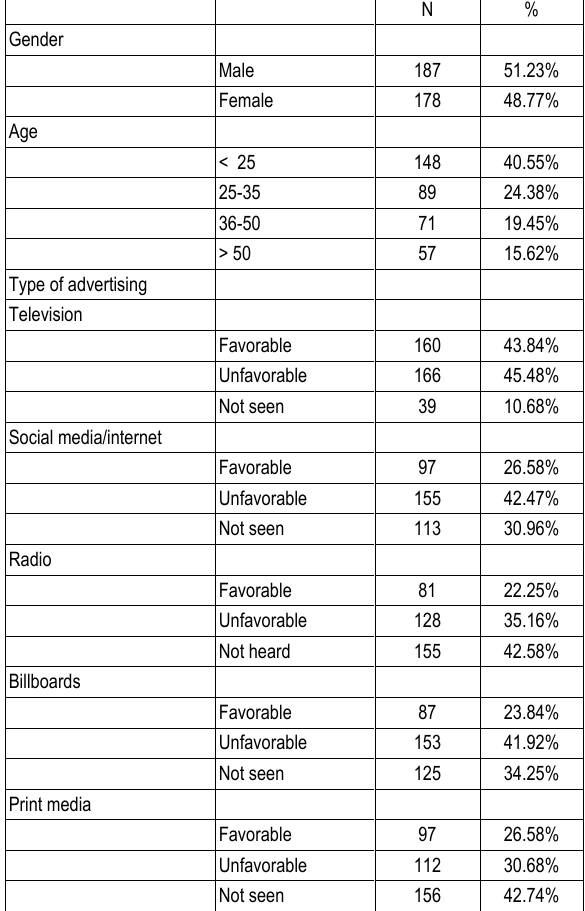
Table 1. Overall